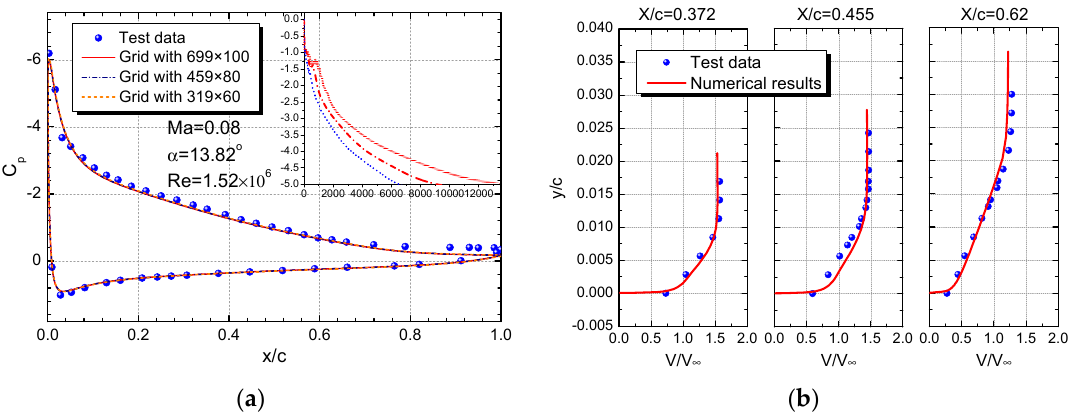
Figure 3. Comparisons of pressure coefficient (Cp) and velocity profiles of NACA4412 airfoil with test data. ( a ) Cp distribution. ( b ) Velocity profiles.